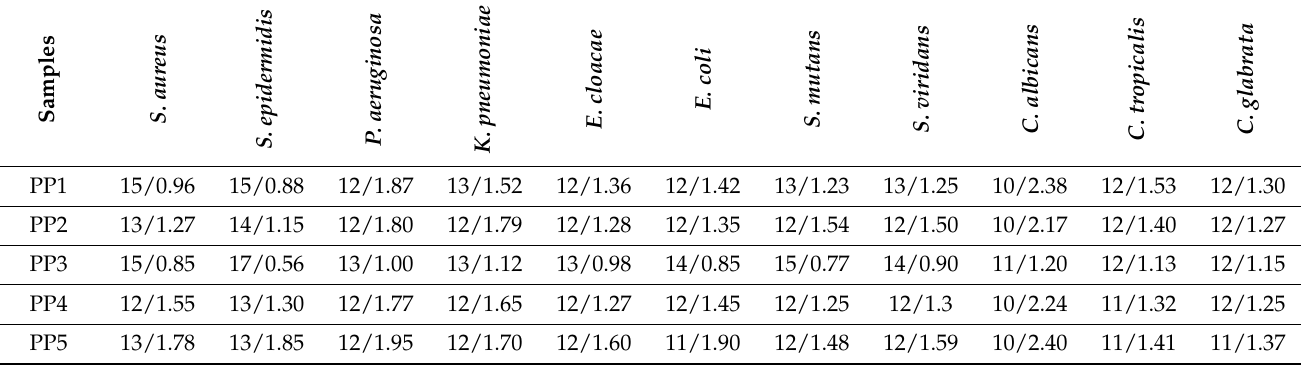
Table 4. Antimicrobial activities (zones of inhibition in mm/ and MIC mg/mL, n =